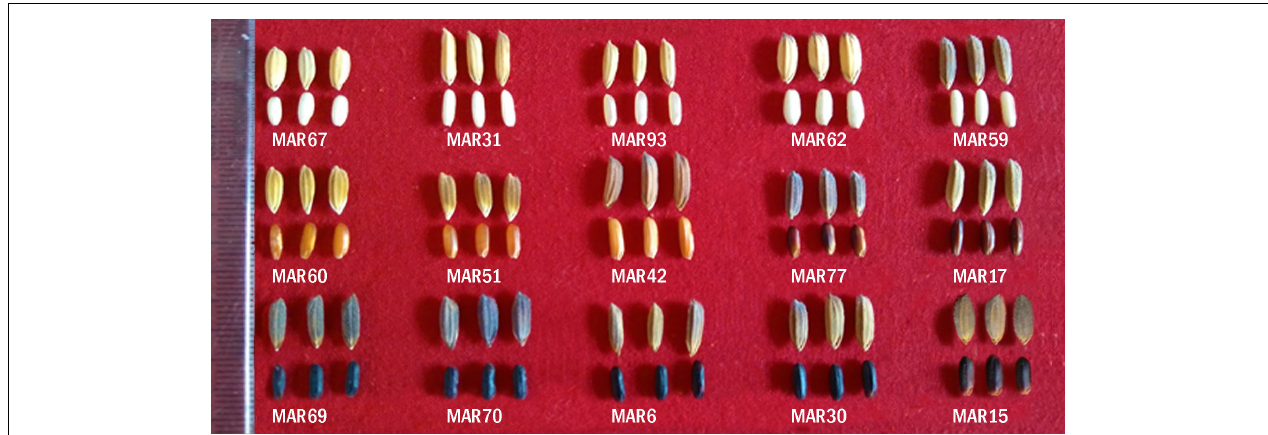
FIGURE 1 | Variation for grain characters in a representative set of aromatic rice germplasm from Manipur. Chakhao Angouba (MAR 67), Napnang Hangmei (MAR 31), Kabo Chakhao (MAR 93), Buhman (MAR 62), Buhman (MAR 59), Buhman (MAR 60), Buhman Te (MAR 51), Chakhao Phou (MAR 42), Ethe Buw (MAR